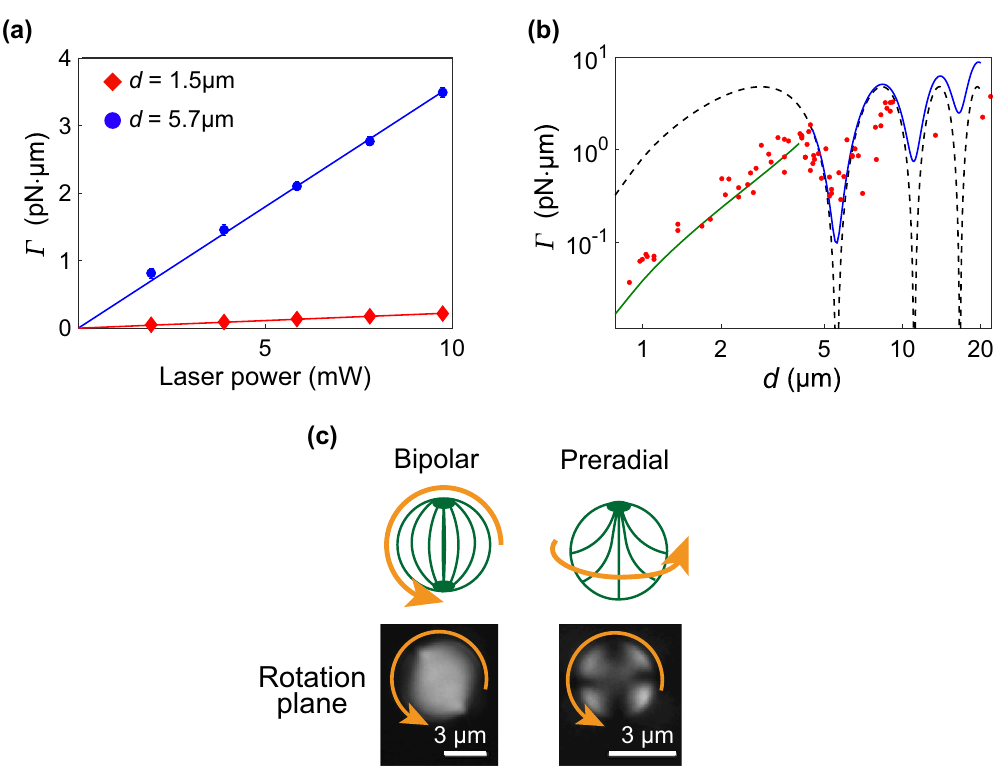
Figure 1. Optically induced continuous rotation of NLC (E7) droplet. ( a ) Variation in optical torque Γ applied to droplet with laser power. The solid lines are the best-fitted ones to data. ( b ) Variation in optical torque Γ with diameter d of droplets. The dashed line is the best-fitted curve of Eq. (3). The green and blue lines are the best-fitted curves of Eq. (4) for d < 4.5 µm and d > 4.5 µm, respectively. ( c ) Polarizing microscopic images of NLC droplet under crossed-nicols polarizers and the schematics of molecular alignment. The molecular alignment within a smaller droplet is preradial, and that within a larger droplet is bipolar. The arrows indicate the rotation